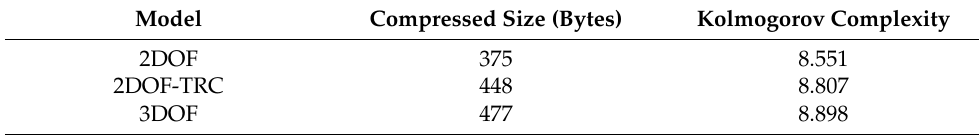
Table 3. Compressed archive file size and KC values of the simple air vehicle